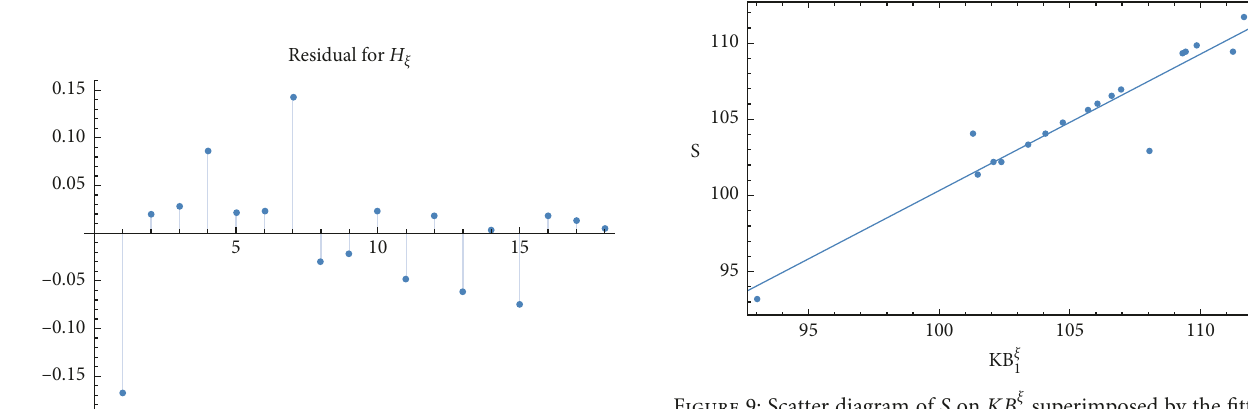
Figure 6: Plot shows the residuals for S on H